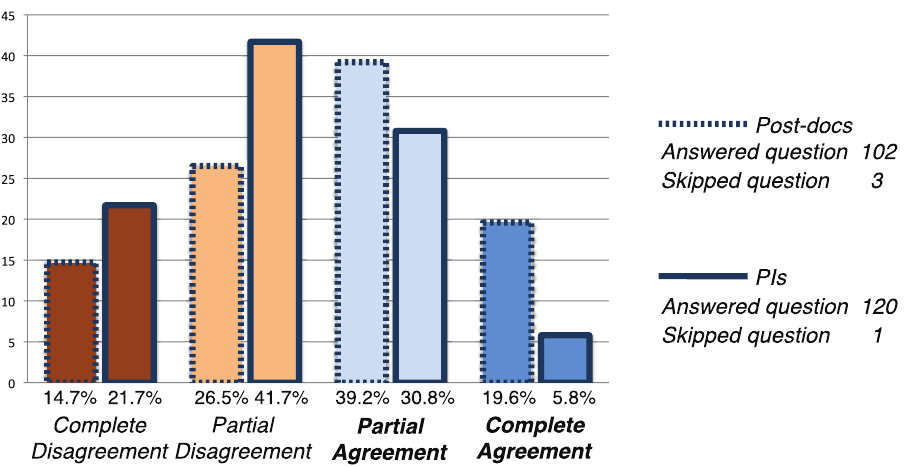
Figure S5. Principal Investigators are sceptical (and more than the post---doctoral researchers) about the effectiveness of discussing potential practical outcome in basic research